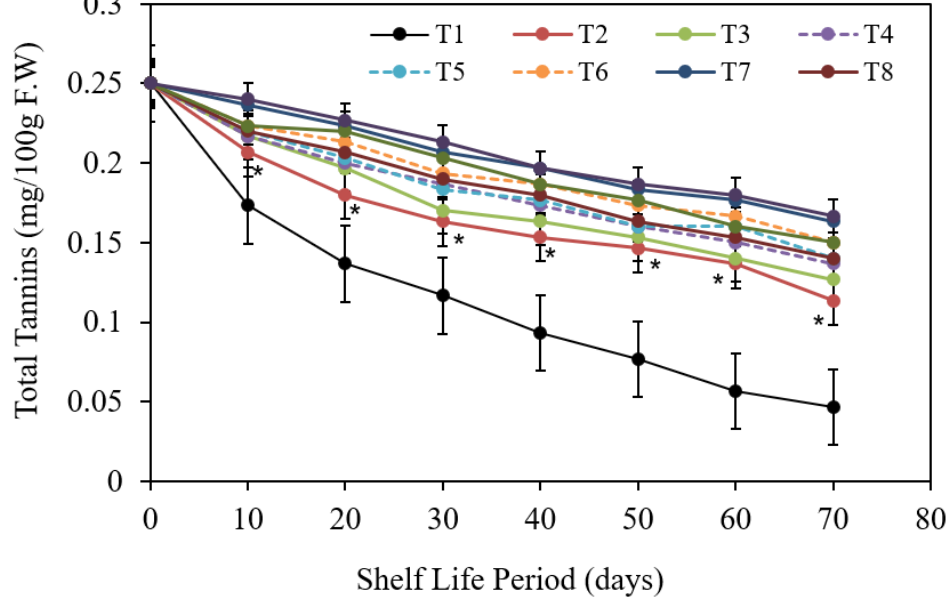
Figure 12. The impact of pre-harvest chitosan, chitosan nanoparticle and CaCl 2 foliar spray treatments on total tannins of Barhi date fruits under cold storing for 70 d. Note that * sign denotes the significant differences between the control and edible coatings treatments, and T1, T2, T3, T4, T5, T6, T7, T8, T9, T10 are water (control), 1 g/L chitosan, 2 g/L chitosan, 3 g/L chitosan, 1 g/L chitosan nanoparticles, 2 g/L chitosan nanoparticles, and 3 g/L chitosan nanoparticles treatments, respectively.